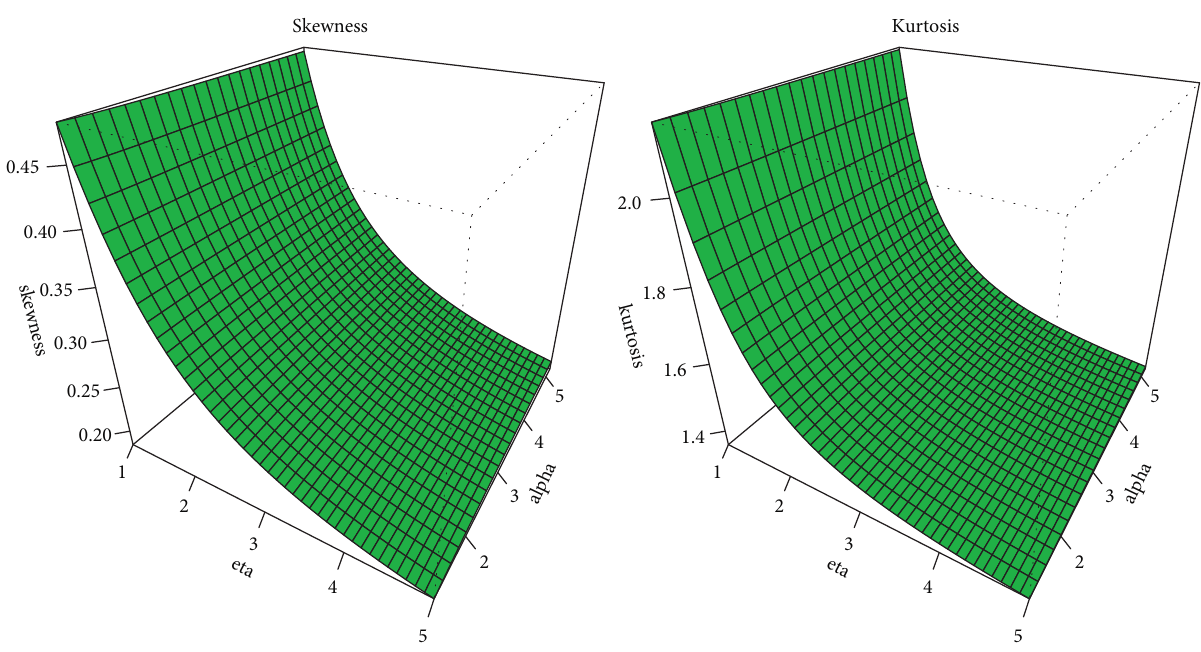
Figure 3: Plots of SK and KU of the IPBH distribution for several values of α and η